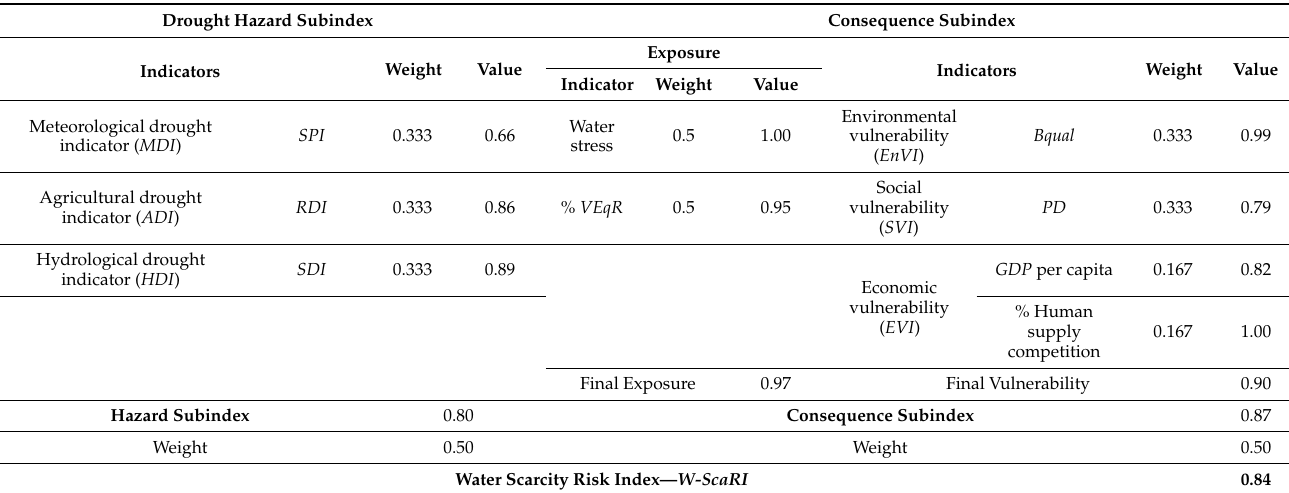
Table 21. W-ScaRI calculation for RJMR—October